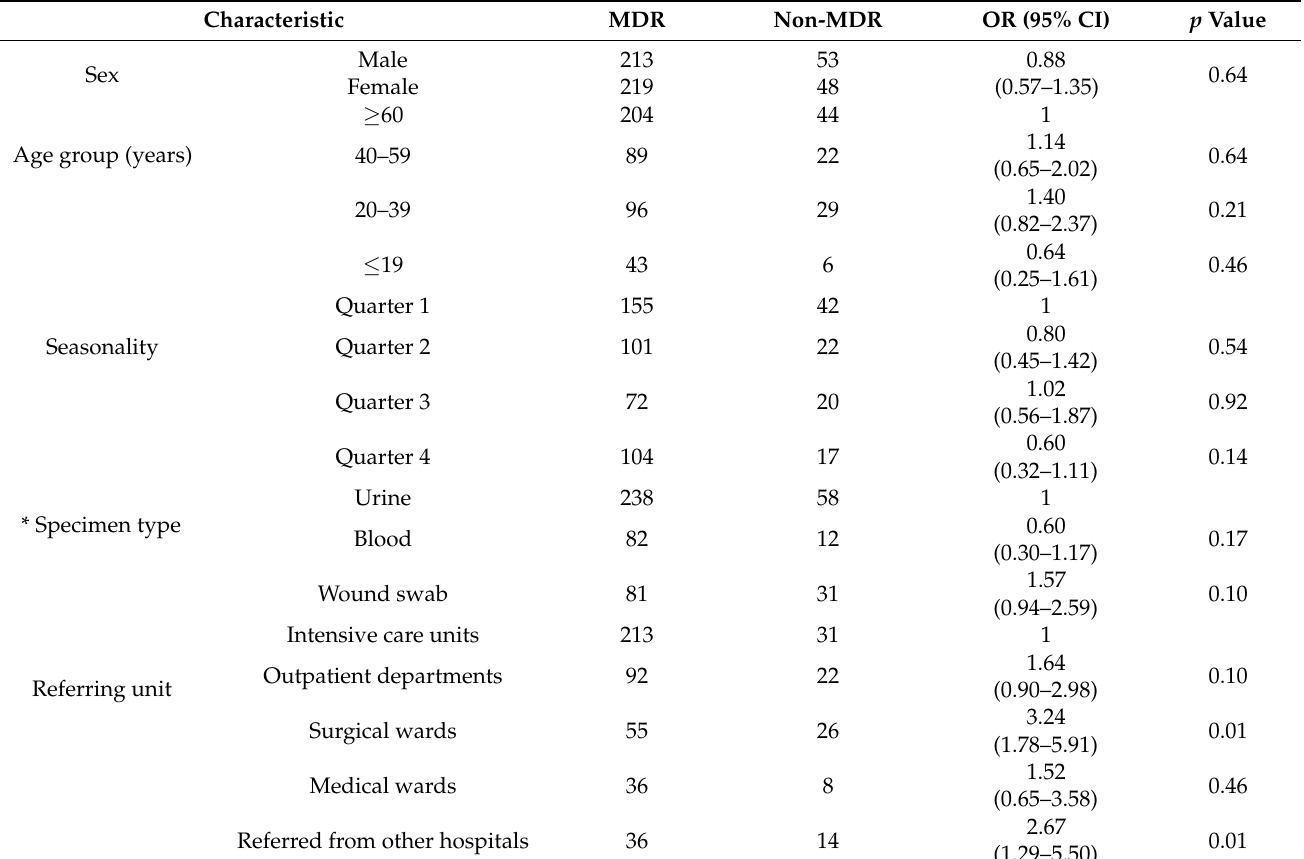
Table 2. Sociodemographic distribution characteristics of multidrug-resistant isolates ( n = 432).